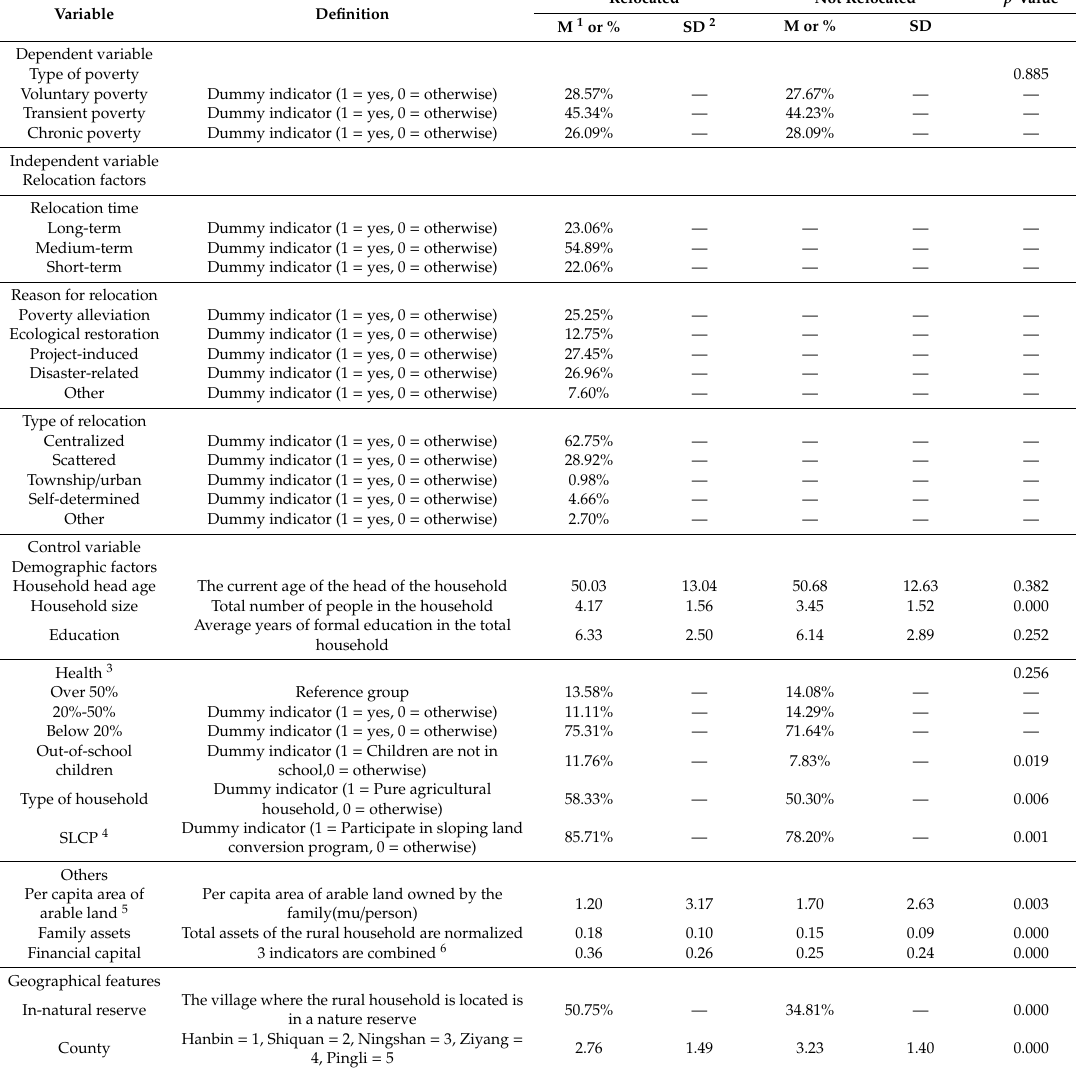
Table 1. Definition and descriptive statistics of the variables in the